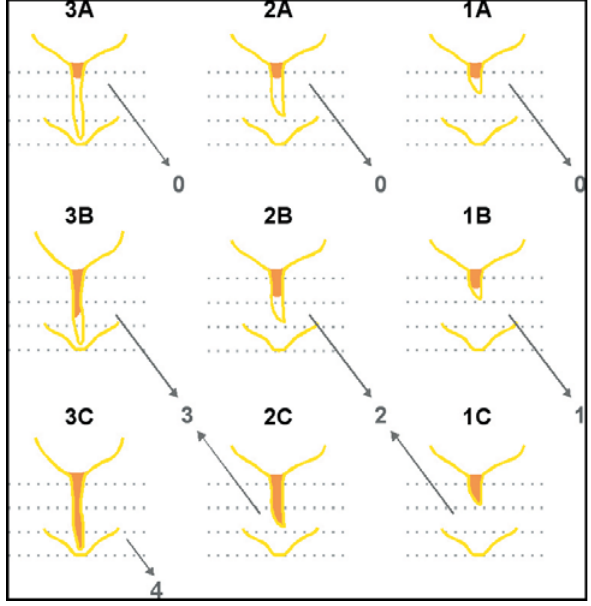
FIGURE 2- Tooth sections displaying fissures sealed with:- (A) resin sealant – score 4 for (MM) and score 3 for (DP); (B) Vitremer – score 0 for (MM) and score 3 for (DP)